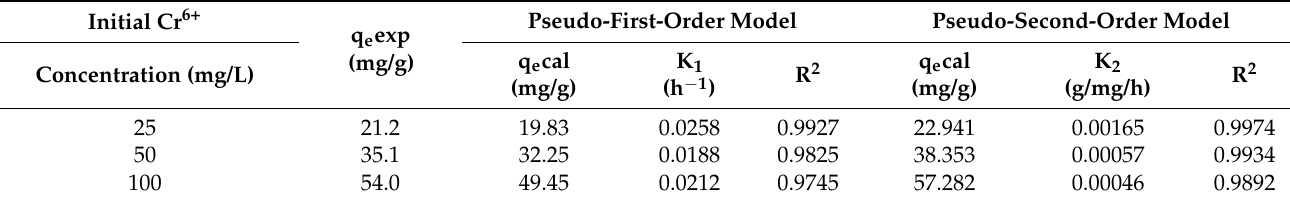
Table 4. Fitting parameter values of the two kinetic